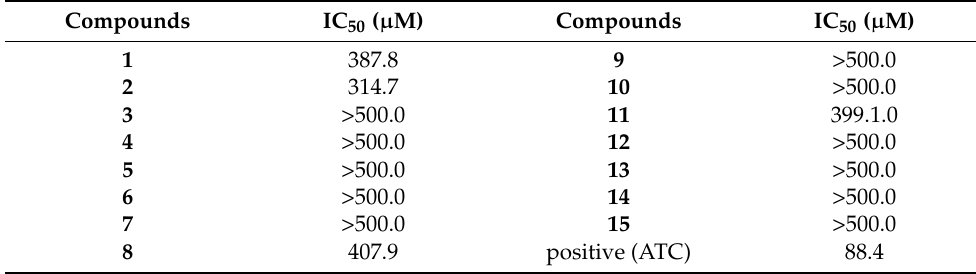
Table 2. The IC 50 value of compounds 1 – 15 and positive (ATC) in BRL